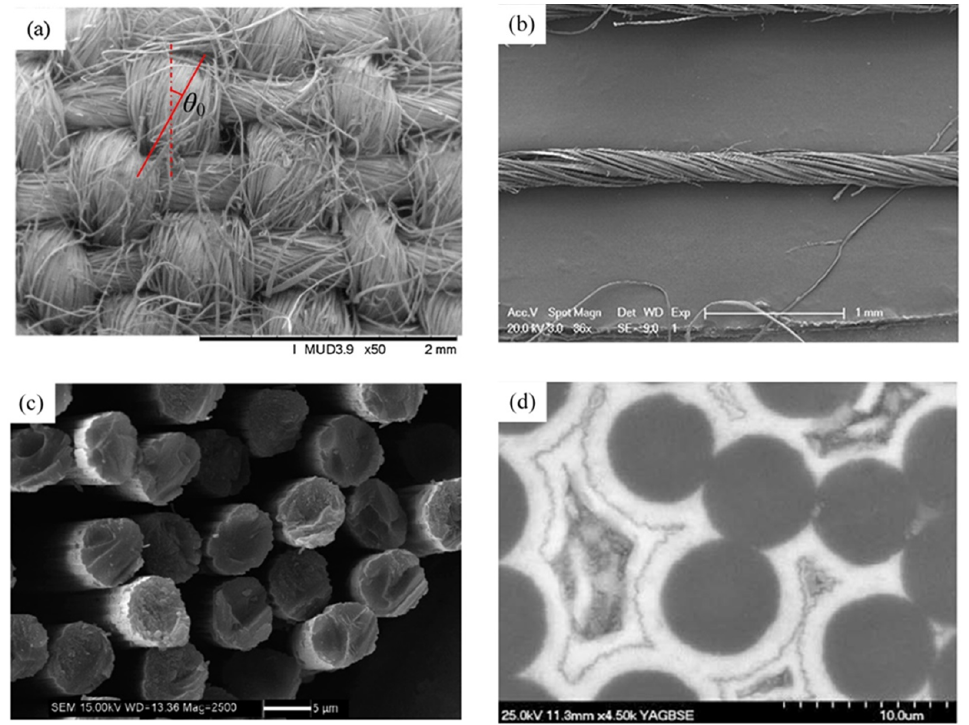
Figure 1. SEM photographs: ( a ) Natural fi ber fabric [24]; ( b ) The orientation of sisal fi bers in the yarn [28]; ( c ) The fi ber rod end surface [29]; ( d ) The fi ber and coating in the yarn [30]. (Reproduced with permission ref. [24]. Copyright 2018 Elsevier; ref. [28]. Copyright 2016 Elsevier; ref. [29]. Copyright 2020 MDPI; ref. [30]. Copyright 2010 Elsevier).